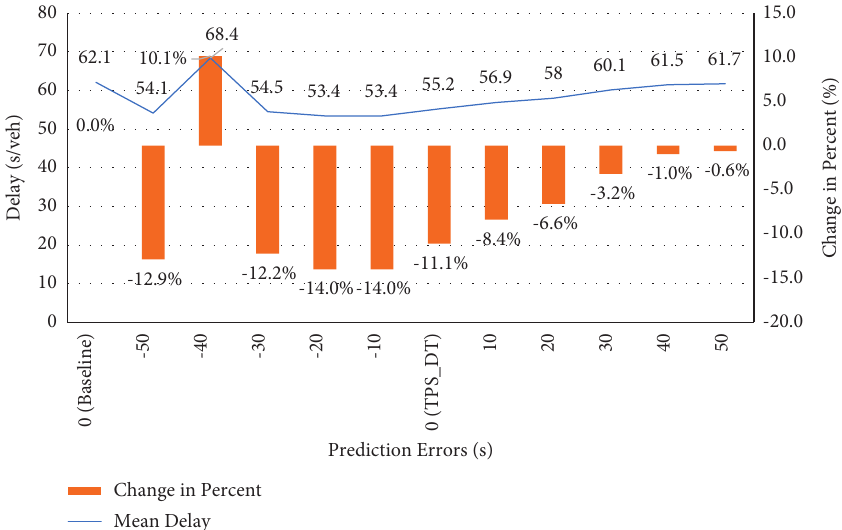
Figure 12: Average delay of the three target intersections near HRGCs versus prediction errors.